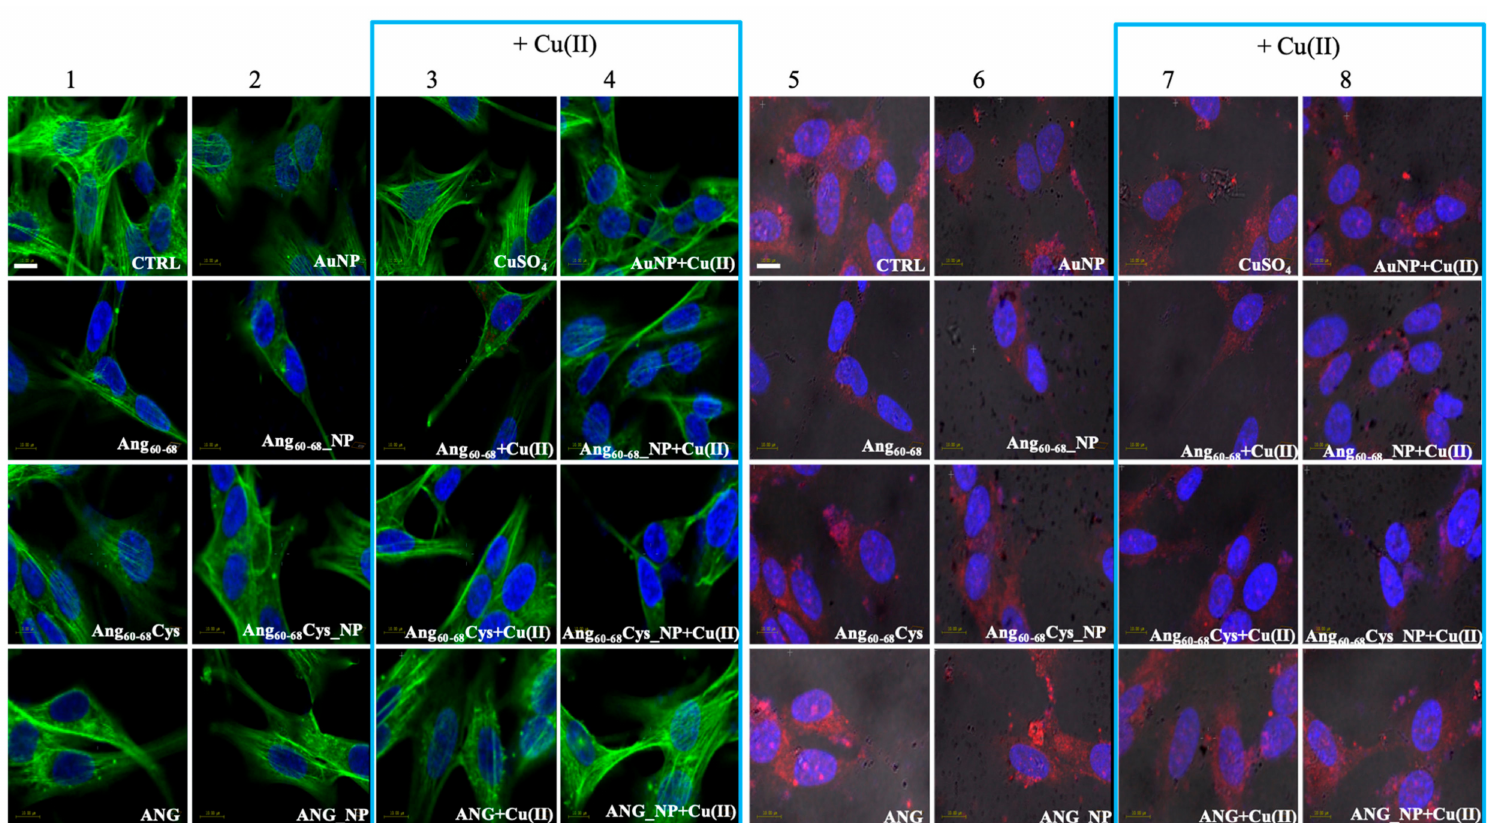
Figure 5. Confocal micrographs of d-SH-SY5Y cells Actin Green ® 488 (in green, ex / em = 488 / 500–530 nm) and Hoechst33342 (in blue, ex / em = 405 / 425–475 nm) were used as F-actin and nuclear markers, respectively. Antibody against angiogenin shows angiogenin localisation in red (ex / em = 543 / 560–700 nm) and micrographs are merged with optical bright field images (in grey). Before treatments, cell were rinsed with fresh culture medium and incubated for 2 h with basal culture medium (control: CTRL) and in culture medium supplemented with: Ang 60–68 (30 µ M), Ang 60–68 Cys (30 µ M); ANG (100 nM), AuNP (9.4 nM = 1.4 × 10 8 NP / mL), Ang 60–68 _NP (1.4 nM = 4.0 × 10 6 NP / mL, [Ang 60–68 ] = 2.8 × 10 − 12 M), Ang 60–68 Cys_NP (1.4 nM = 4.0 × 10 6 NP / mL, [Ang 60–68 Cys] = 2.6 × 10 − 12 M), ANG_NP (1.2 nM = 3.4 × 10 6 NP / mL, [ANG] = 0.2 × 10 − 12 M). Scale bar = 10 µ